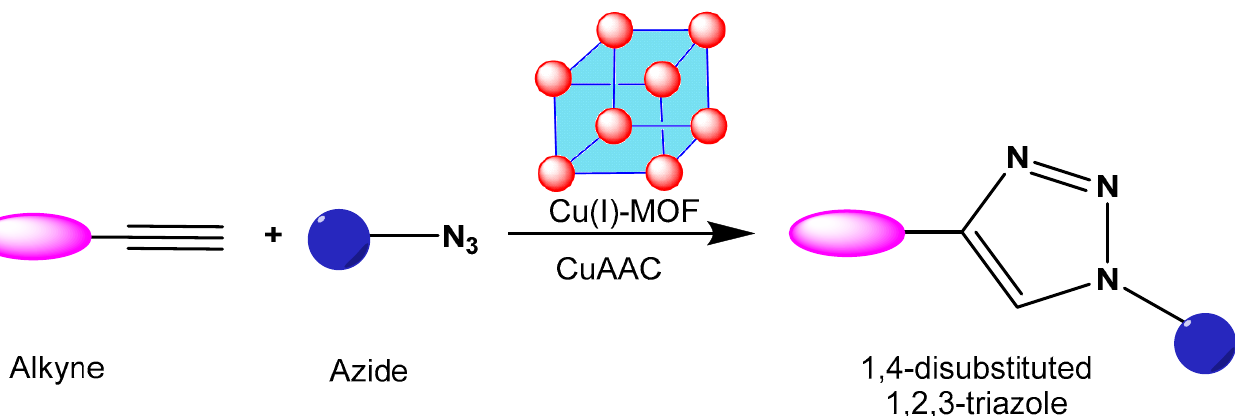
Figure 10. General reaction scheme depicting the formation of 1,4-disubstituted 1,2,3-triazole.